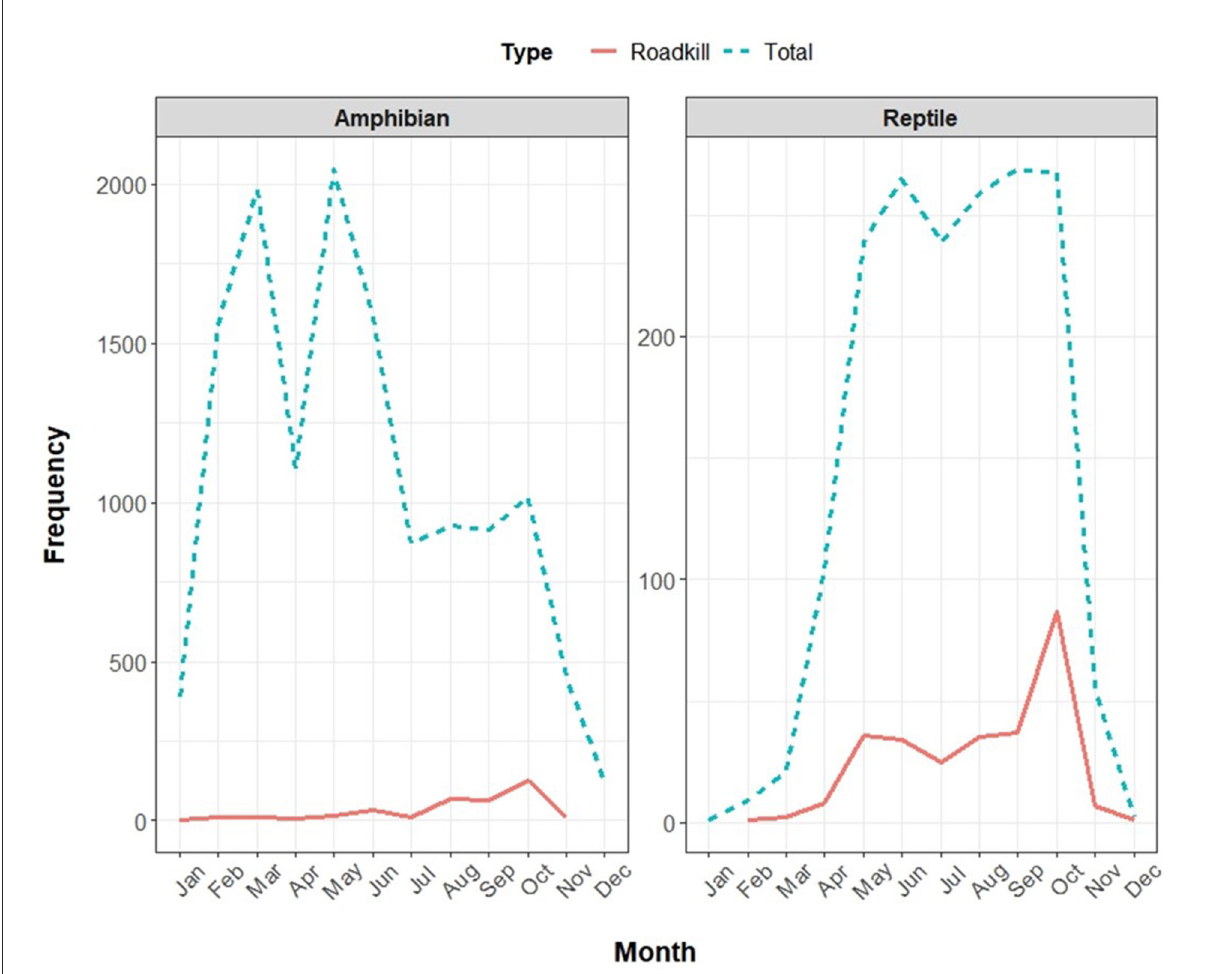
FIGURE7 The total monthly roadkill records for the Korean herpetofauna (total n monthly observations (total n January 2005 to 13 August 2020. Distinctly different monthly trends are notable between the total observations and roadkill observations for both amphibian and reptile datasets, highlighting that the peaks in the number of roadkills do not match the peaks in the number of total